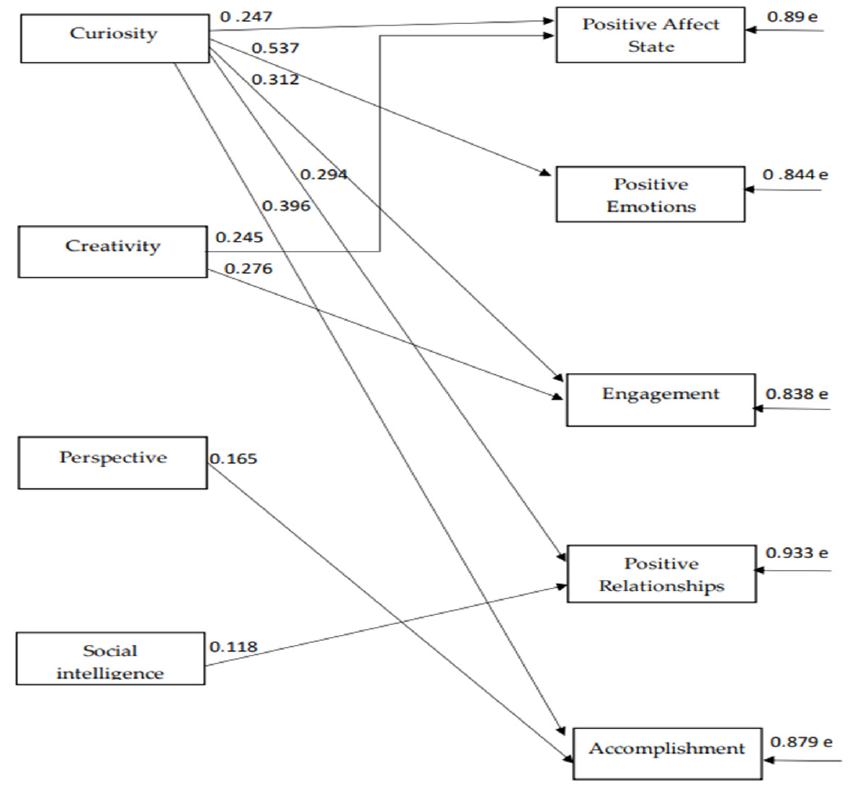
Figure 3. The relationships between virtue of intellect dimensions and subjective wellbeing com- ponent.